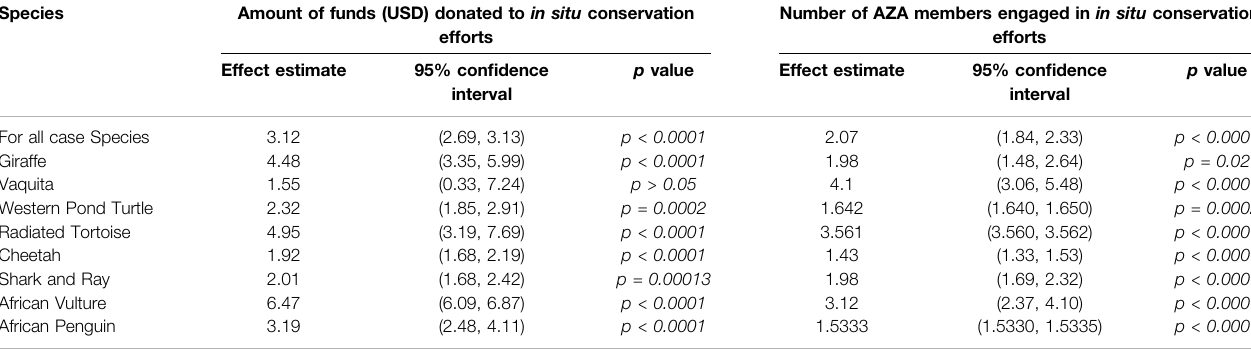
TABLE 2 | Effect of SAFE program initiation on amount of money donated to and number of AZA member facilities engaged in in situ conservation efforts across the eight selected case species. Regression coef fi cient (Effect Estimate), 95% con fi dence interval, and p -value produced by individual models are provided for each species.